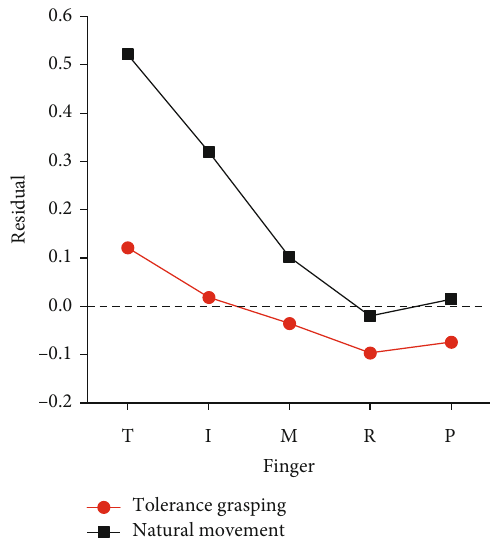
Figure 4: Analysis of the fi nger movement independence in tolerance grasping, cortical representation, and natural movement of unstructured environment. The cortical representation and natural movement in unstructured environment results are replotted from [9, 41].